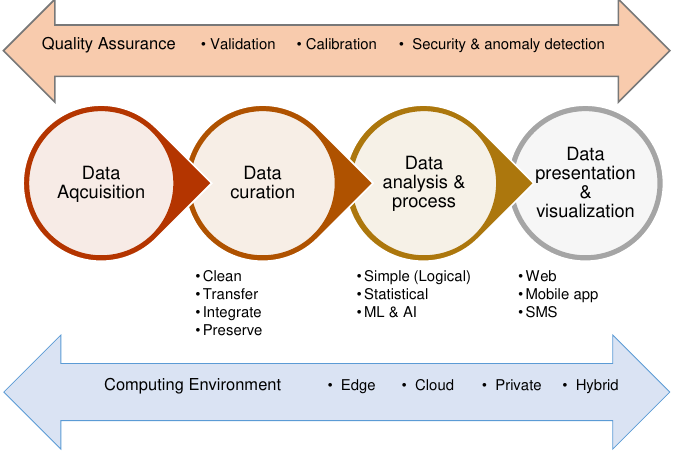
Figure 9. A general dataflow schema in data science computations.